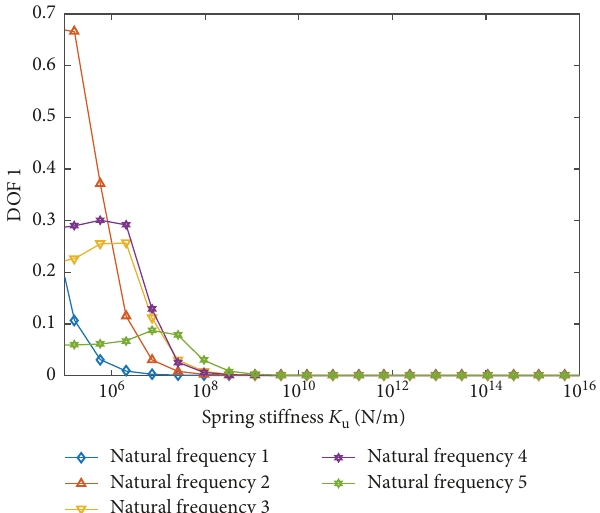
K � 8 × 10 5 (SI units). Fixed-free u and Δ θ